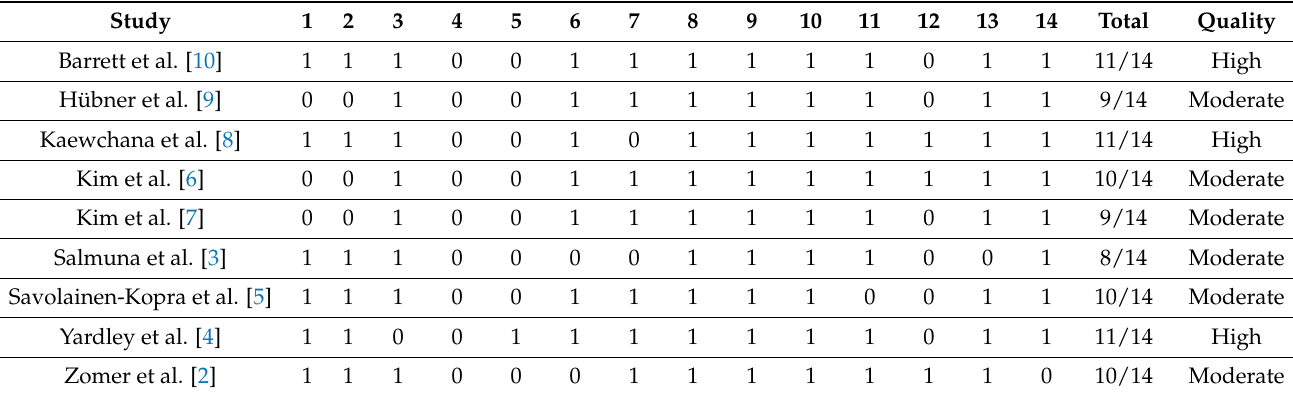
Table 2. Quality assessment of randomized control-trial based on the National Heart, Lung and Blood Institute guidelines for enrolled studies